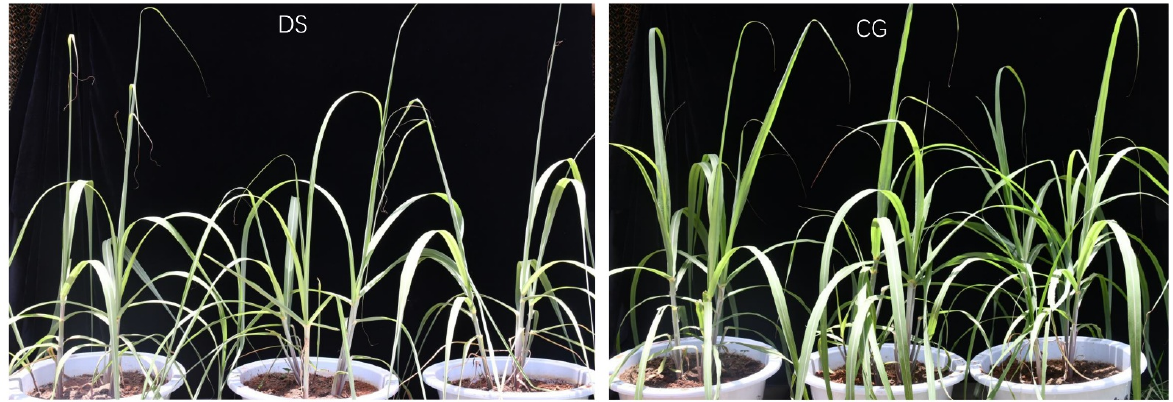
Figure 1. Phenotype of Badila with drought stress (DS; left ) or normal watering (control group, CG; right ).